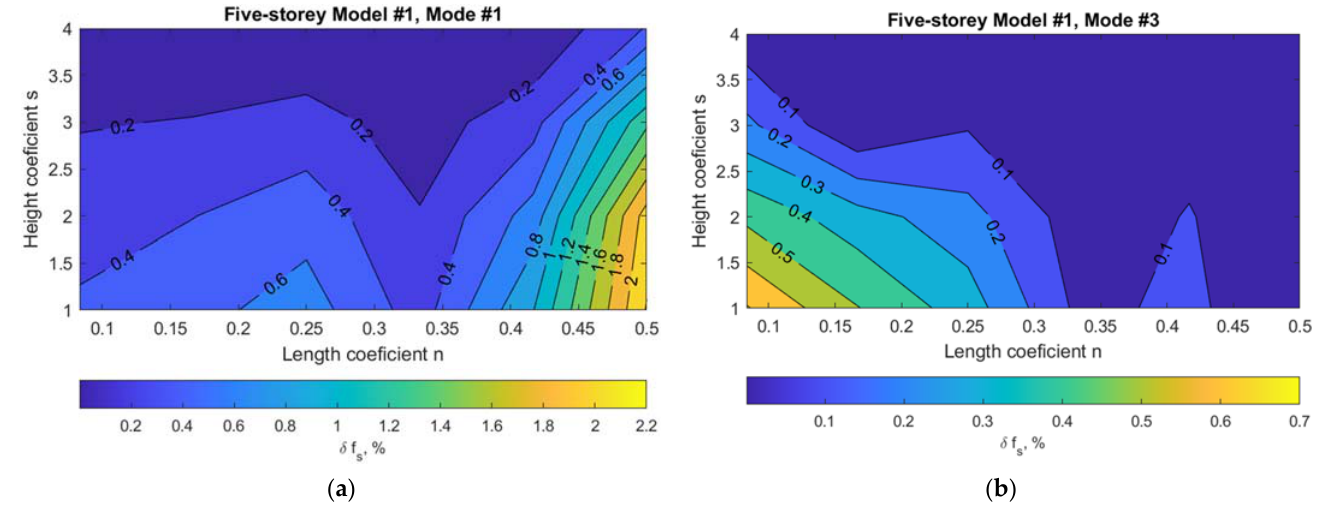
Figure 8. Variation of structural frequency f s due to damage scenario for reference five-story Model #1: ( a ) mode #1 (lateral); ( b ) mode #3 (torsional).